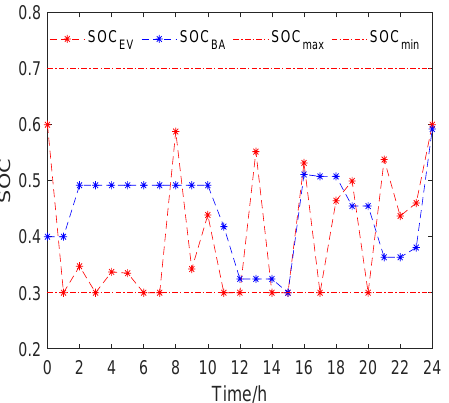
Figure 10. The battery and EV SOC under the objective function solving by